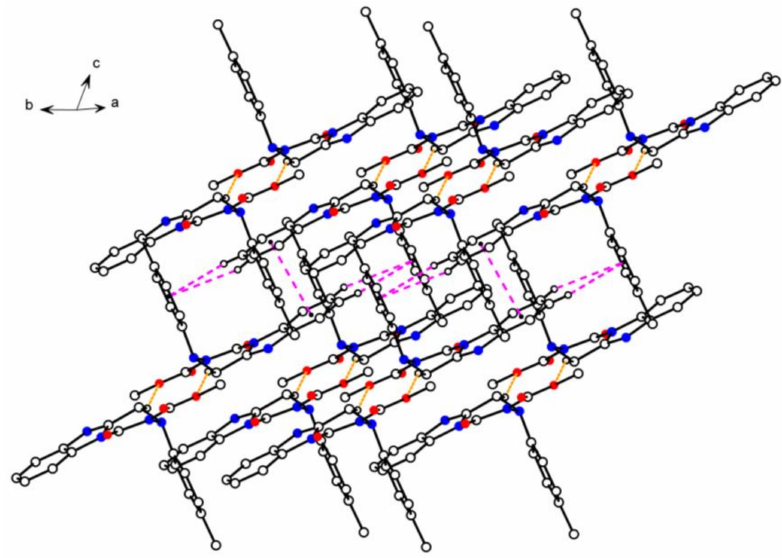
Figure 3. Crystal packing diagram of compound 4n . Yellow dashed lines show intermolecular hydrogen bonds. Pink dashed lines show π ··· π